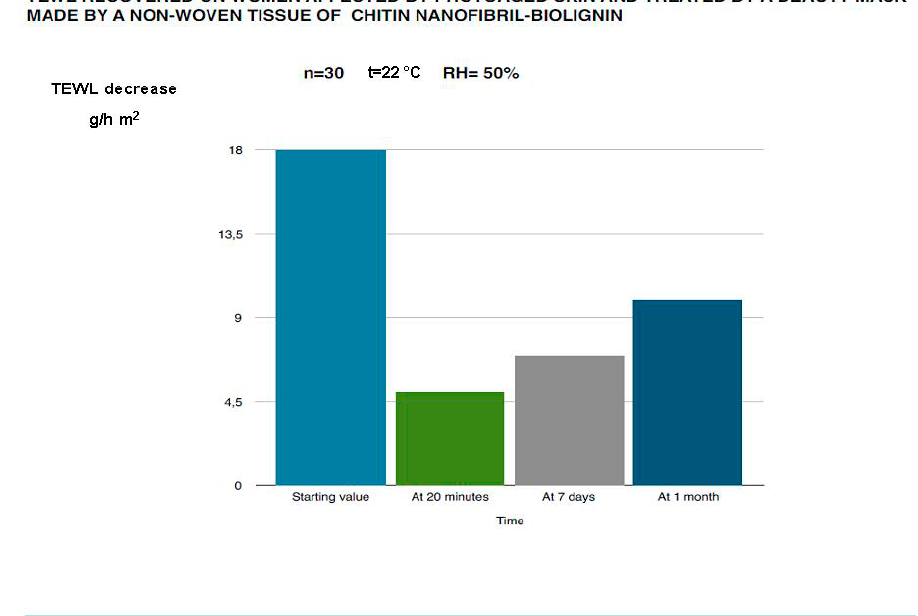
Figure 9. Effectiveness of the mask on the skin lipids balance of photoaged women.